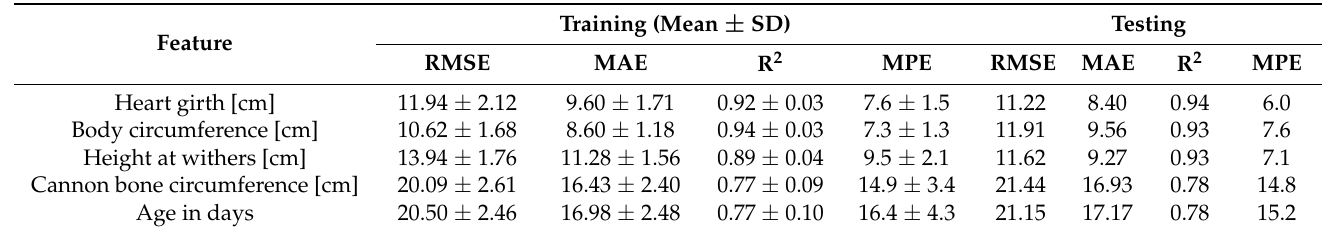
Table 2. Root-mean-square error (RMSE), mean absolute error (MAE), coefficient of determination (R 2 ) and mean percentage error (MPE) from the cross-validation using the training and testing datasets for linear models featuring one independent variable for the prediction of body weight in Icelandic